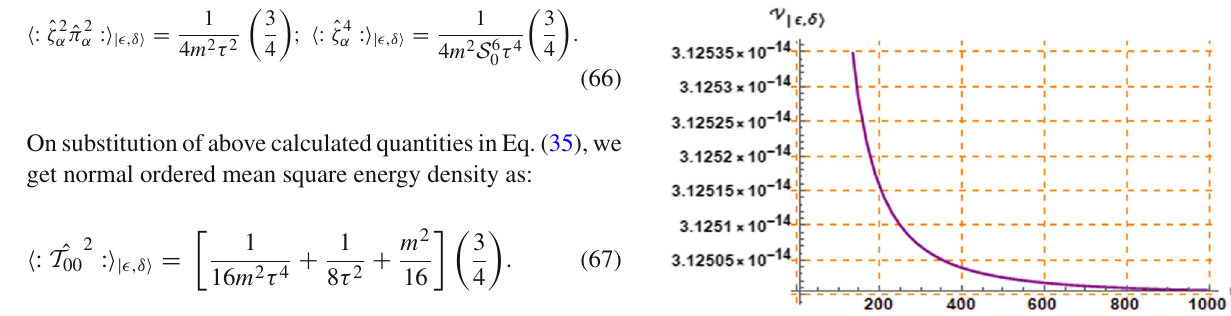
Fig. 3 Densityfluctuations V T | (cid:11),δ (cid:3) inTMCstatesisplottedasafunction of m τ